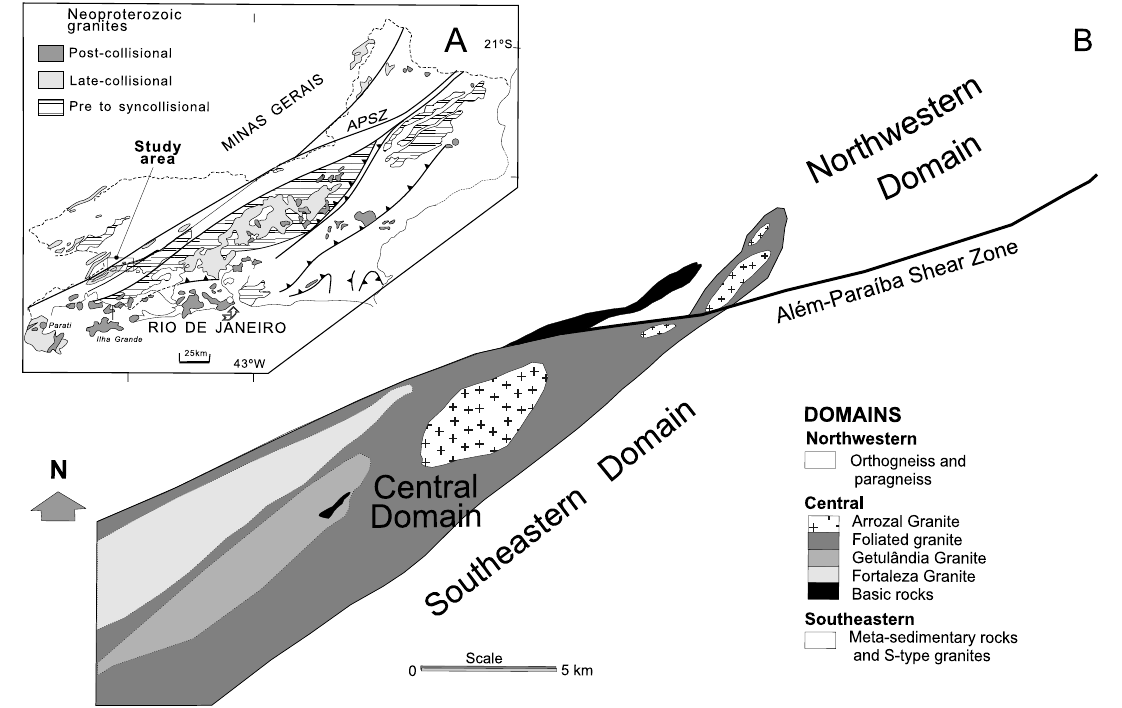
Fig. 1 – (A) Geological sketch map of the Neoproterozoic granites of the State of Rio de Janeiro (B) and Map of the Arrozal